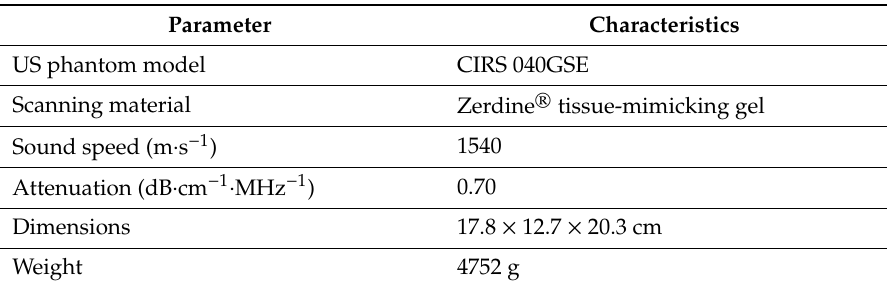
Table 1. US phantom